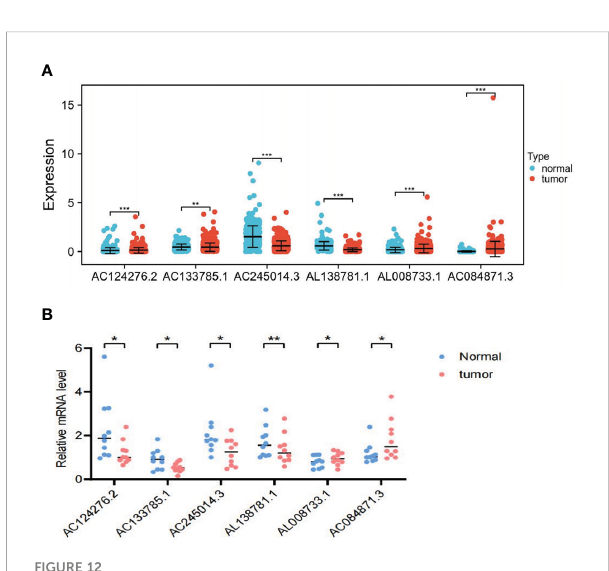
FIGURE 12 In vitro experimental validation. (A) Differential expression of the six LRLs (AC124276.2, AC133785.1, AC245014.3, AL138781.1, AL008733.1, and AC084871.3) in the tumor and normal group. (B) The RT-PCR results show the expression of the six LRLs in 10 pairs of PTC and normal tissues. *p<0.05, **p<0.01, ***p<0.001, p<0.05 was considered signi fi